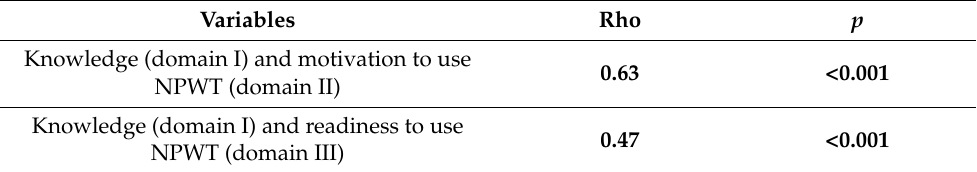
Table 8. Assessment of the relationship between the overall readiness to implement NPWT and the age and level of education. Variables Rho p Total NPWT Perception Score and Age − 0.04 0.398 Total NPWT Perception Score and Age and level of 0.03 0.507 nursing education